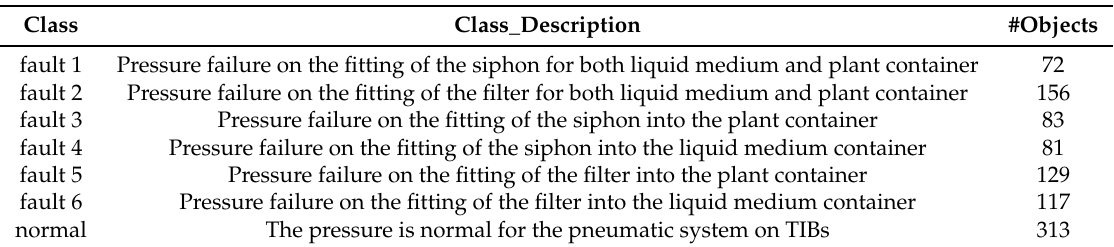
Table 1. Description of our micropropagation pineapple database, proposed in this paper, for detecting pneumatic failures on